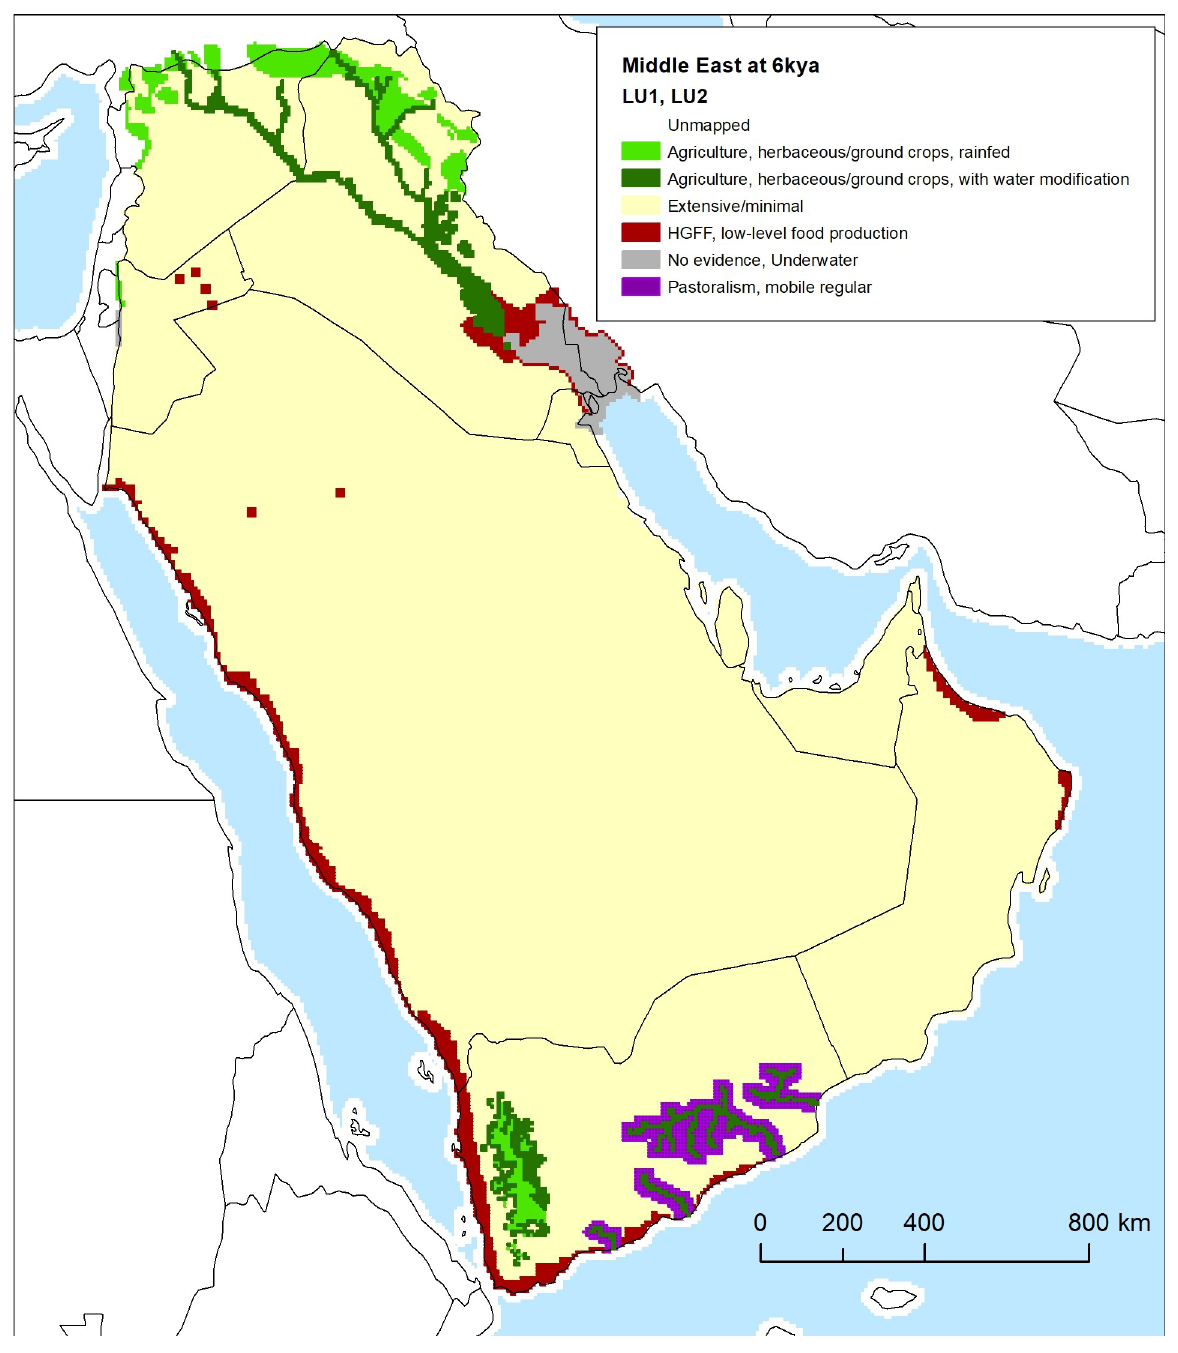
Fig 10. Mesopotamia and Arabia land use at 6 kya, an example using the classification scheme, geodatabase, and classification processes outlined in the paper. Explanations for how the classification has been applied and citations for archaeological data used in this example are discussed throughout the